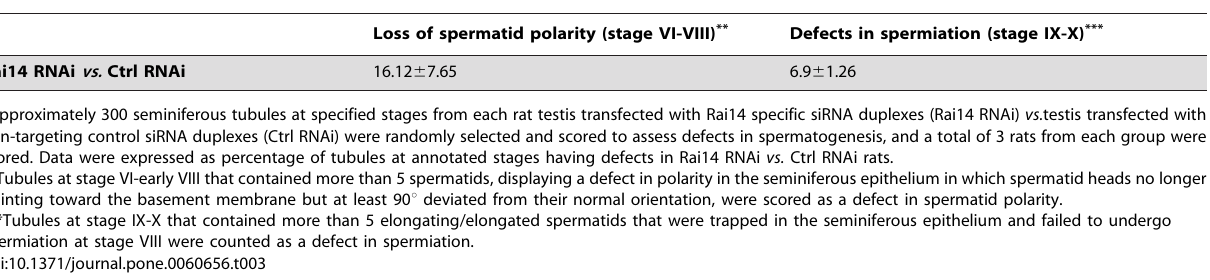
Loss of spermatid polarity (stage VI-VIII) ** Defects in spermiation (stage IX-X) *** Rai14 RNAi vs. Ctrl RNAi